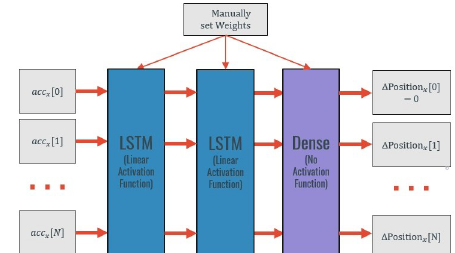
Figure 4. Representation of the warm-Start with “integrative” weights methodology—example for the